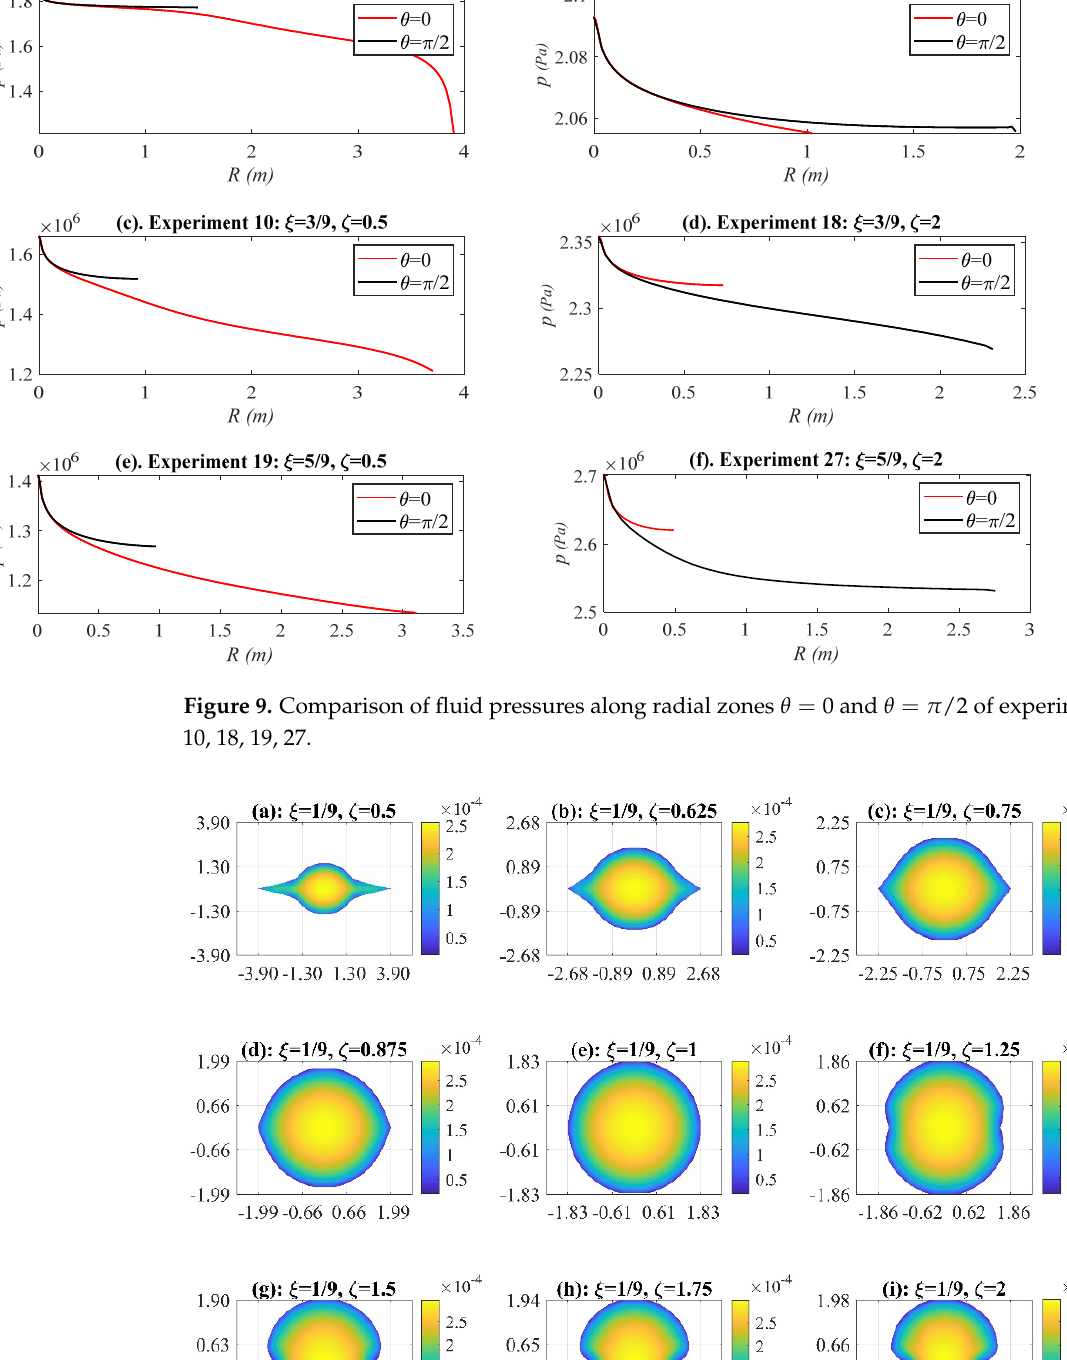
Figure 8. Distributions of fluid pressure of Group 3 numerical experiments ( 𝜉 = 5 9⁄ ) with 9 differ- ent fracture toughness contrasts at the moment = 20 s .